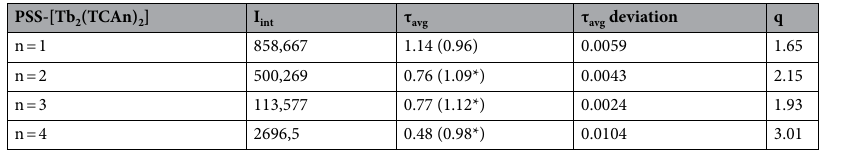
Table 2. The integral intensities (I int ) evaluated for the four emission bands in the range 470–635 nm, average lifetime values (τ avg ) measured in PSS-[Tb 2 (TCAn) 2 ] (0.75 mM) along with the τ avg values for the complexes in the DMF solutions presented in brackets, and the hydration numbers (q) calculated from the luminescence measurements. *- τ avg values in DMF 39